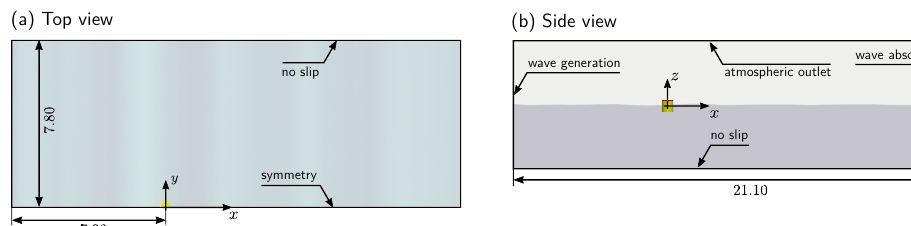
Figure 5. Schematic of the numerical wave tank (all dimensions in [m]): ( a ) top view and ( b ) side view. Computational